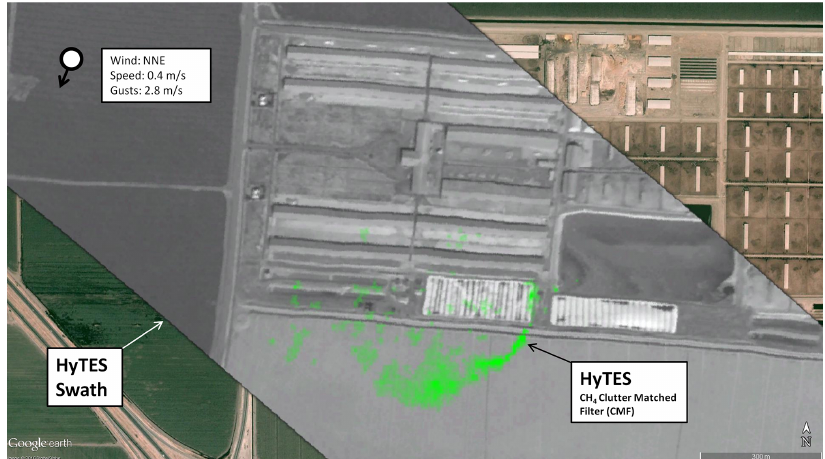
Figure 9. HyTES-detected methane plumes over a dairy farm in the San Joaquin Valley, California, during February 2015 displayed in Google Earth with the methane plume in green overlayed on HyTES grayscale surface temperature retrieval. The dispersion of the detected plume is consistent with wind measurements in the local area (from NNE at 0.4ms − 1 with gusts to 2.8ms − 1